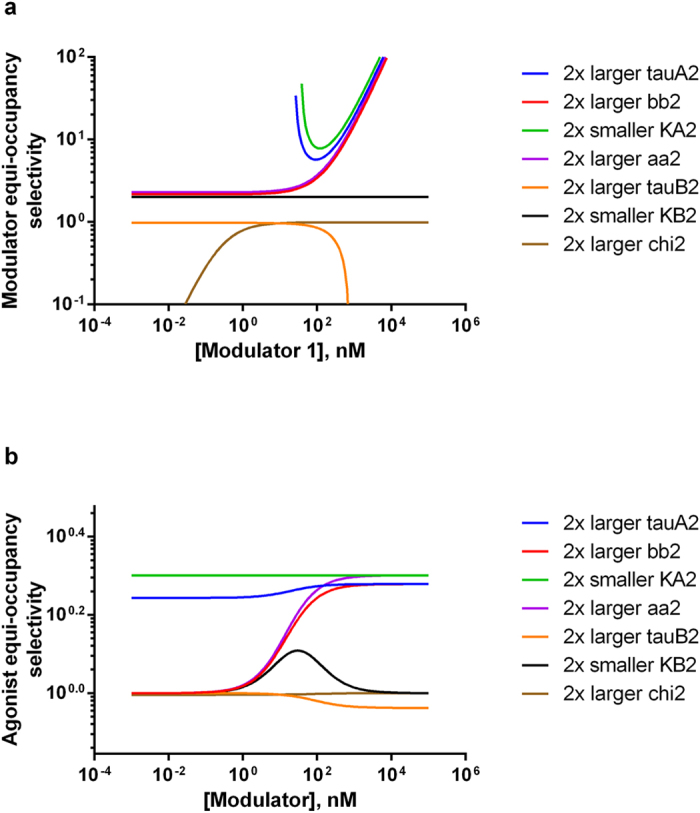
Modulator or agonist equi-occupancy selectivity 2D plots.All simulations for modulator (a) or agonist (b) equi-occupancy selectivity plots use equation (13) for (a) and equation (15) for (b) and the following parameters values (unless indicated otherwise in the label legend): KA1 = KA2 = KB1 = KB2 = 100 nM, chi1 = chi2 = 0.01, tauA1 = tauA2 = 3, tauB1 = tauB2 = 0.1, n1 = n2 = 1, aa1 = aa2 = 2, bb1 = bb2 = 3, RR = 1. Modulator concentrations are varied over 8 orders of magnitude.